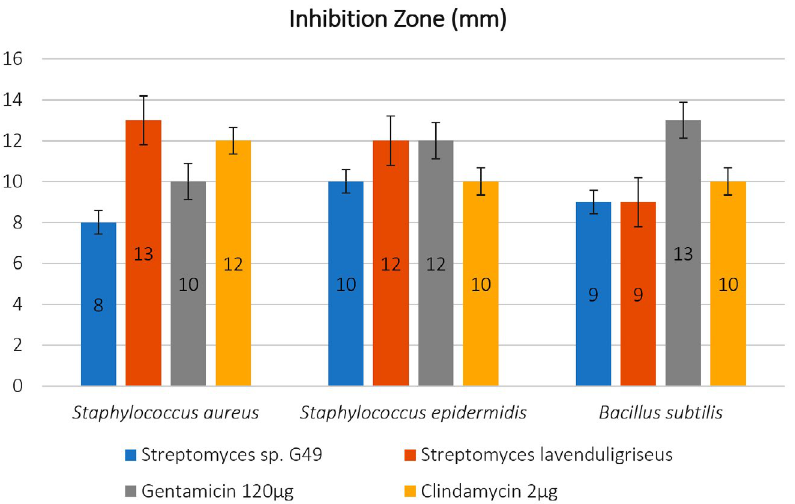
Fig. 4. Antagonistic activity of Actinomycetes isolates by mm against pathogens ( Staphylococcus aureus ATCC 6538; Staphylococcus epidermidis ATCC 12228; Bacillus subtilis ) with 125 μl of extract comparing with two stander antibiotic Gentamicin 120μg and Clindamycin 2